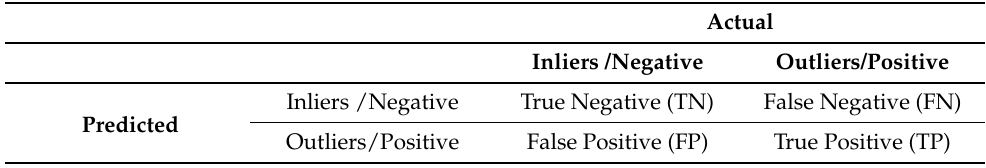
Table 1. Confusion